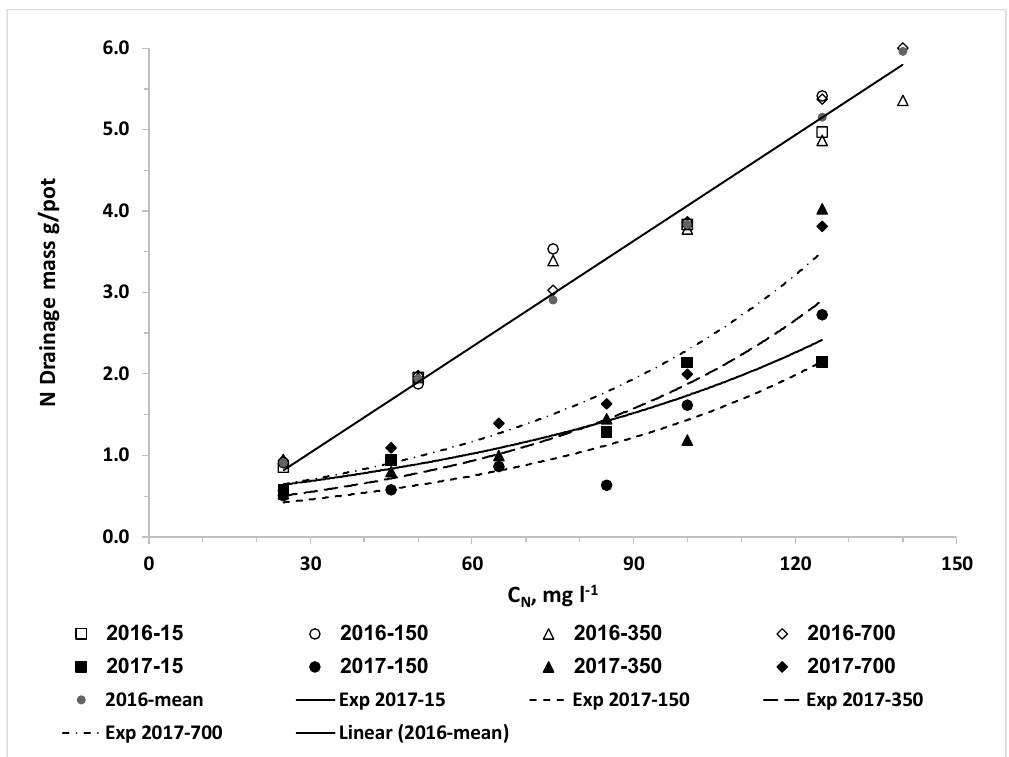
Figure 3. N mass in the leachate of lettuce experiments: 2016 and 2017. The equations of the best fit curves presented in Figure 3 are as follows: 2016, C Cl = 15, Y = 0.4217e 0.0137X , R 2 = 0.873. 2016, C Cl = 150, Y = 0.2834e 0.0162X , R 2 = 0.803. 2016, C Cl = 300, Y = 0.3277e 0.0174X , R 2 = 0.862. 2016, C Cl = 700, Y = 0.425e 0.0169X , R 2 = 0.952. 2017, Mean C Cl , Y = 0.0432X − 0.261, R 2 =